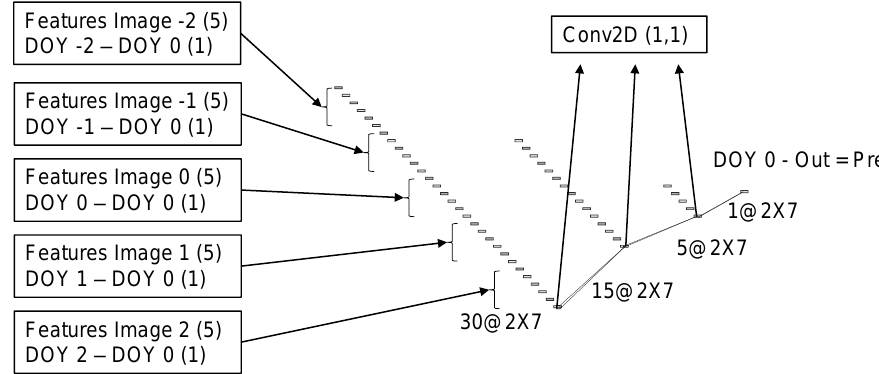
Figure 6. Schematic representation of the multi date convolutional neural network architecture. The numbers represent the dimensions of the tensors and the names in the boxes are the operations applied. The DOY stands for the day of year.